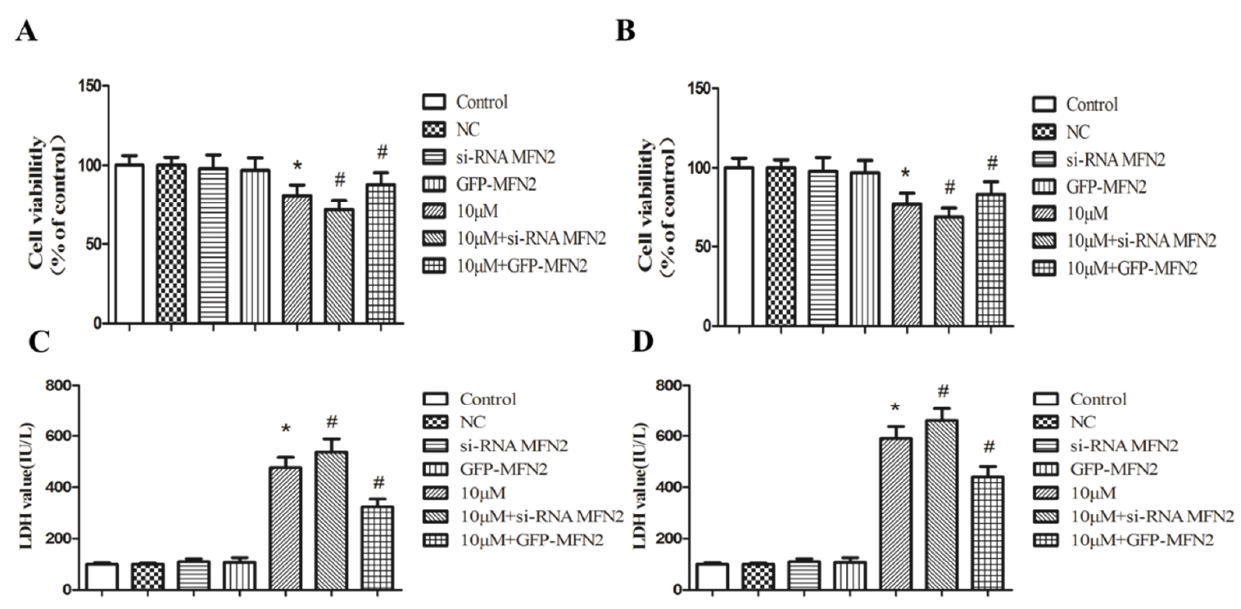
Figure 6. Loss of MFN2 primes the cytotoxicity of Pb . MFN2 expression was upregulated and downregulated in PC12 cells by transfection of pCMV3-MFN2 overexpressing vector and siRNAs, respectively. The effect of Pb on cell viability was determined by MTT ( A , B ) and LDH ( C , D ) assay. The data are expressed as mean ± SD of three independent experiments. * p < 0.05 compared with control group; # p < 0.05 compared with Pb-treated group.